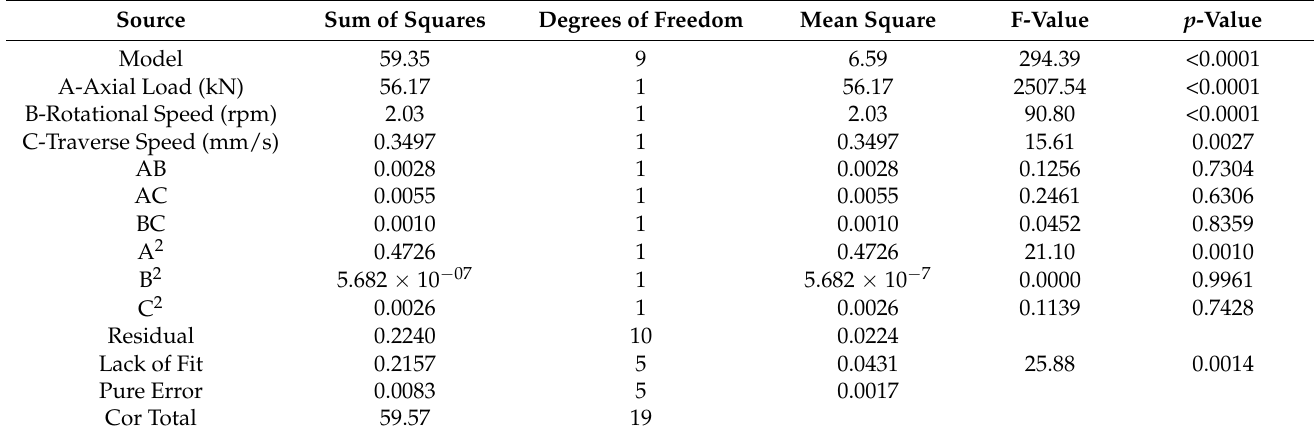
Table 6. ANOVA for quadratic model—Response 2: Coating width (C w